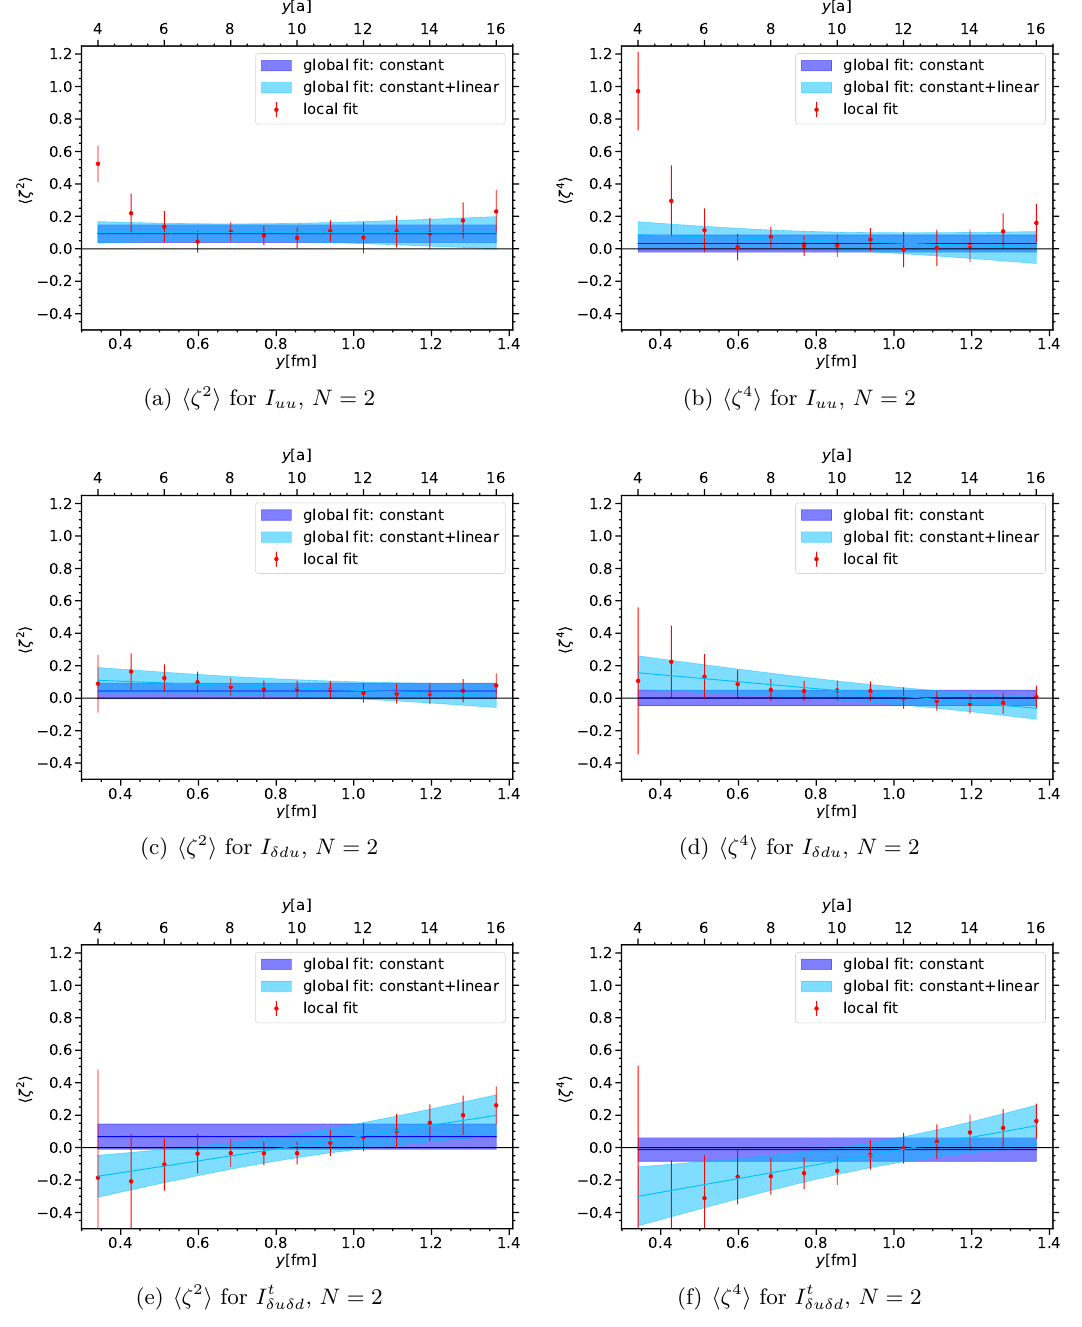
Figure 17 . The same as figure 16 for the second (left) and fourth (right) moment of ζ in I uu , , where only results for N = 2 are I δdu , and I t δuδd